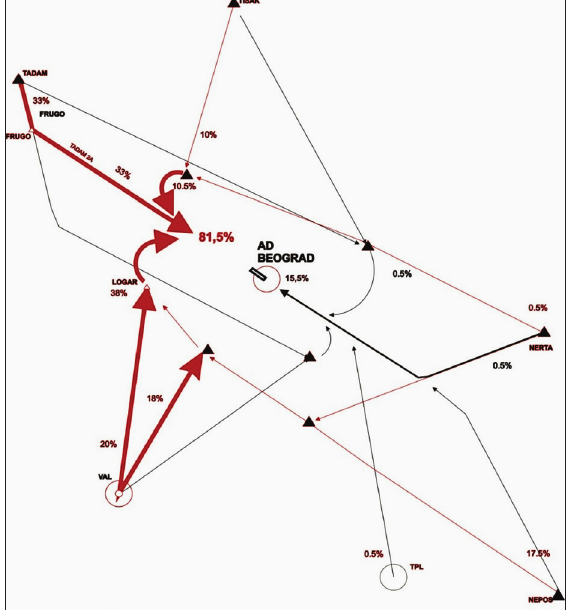
Fig. 8. The distribution of emissions during arrival on an average summer day of